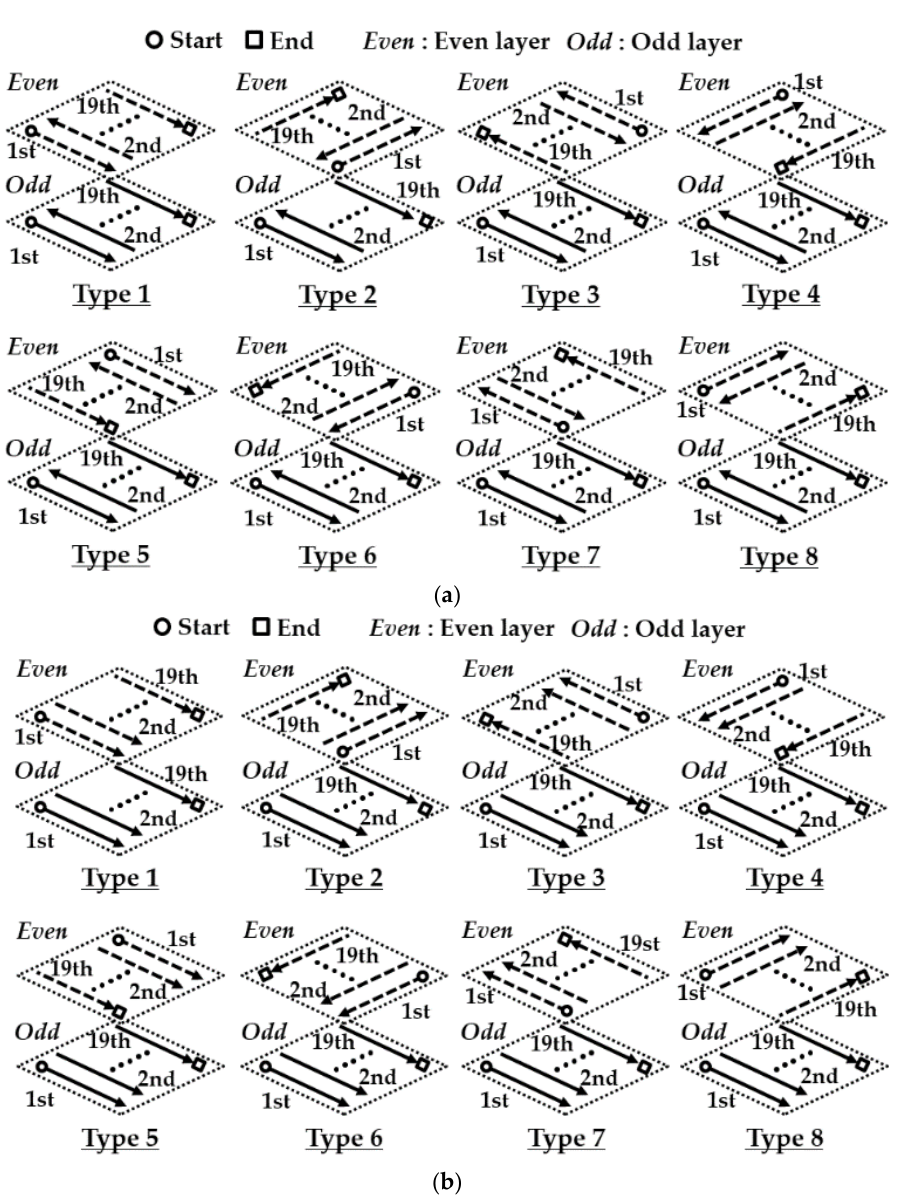
Figure 3. Deposition strategies for FEAs: ( a ) alternative directional deposition strategies (ADDSs); ( b ) uni-directional deposition strategies (UDDSs).